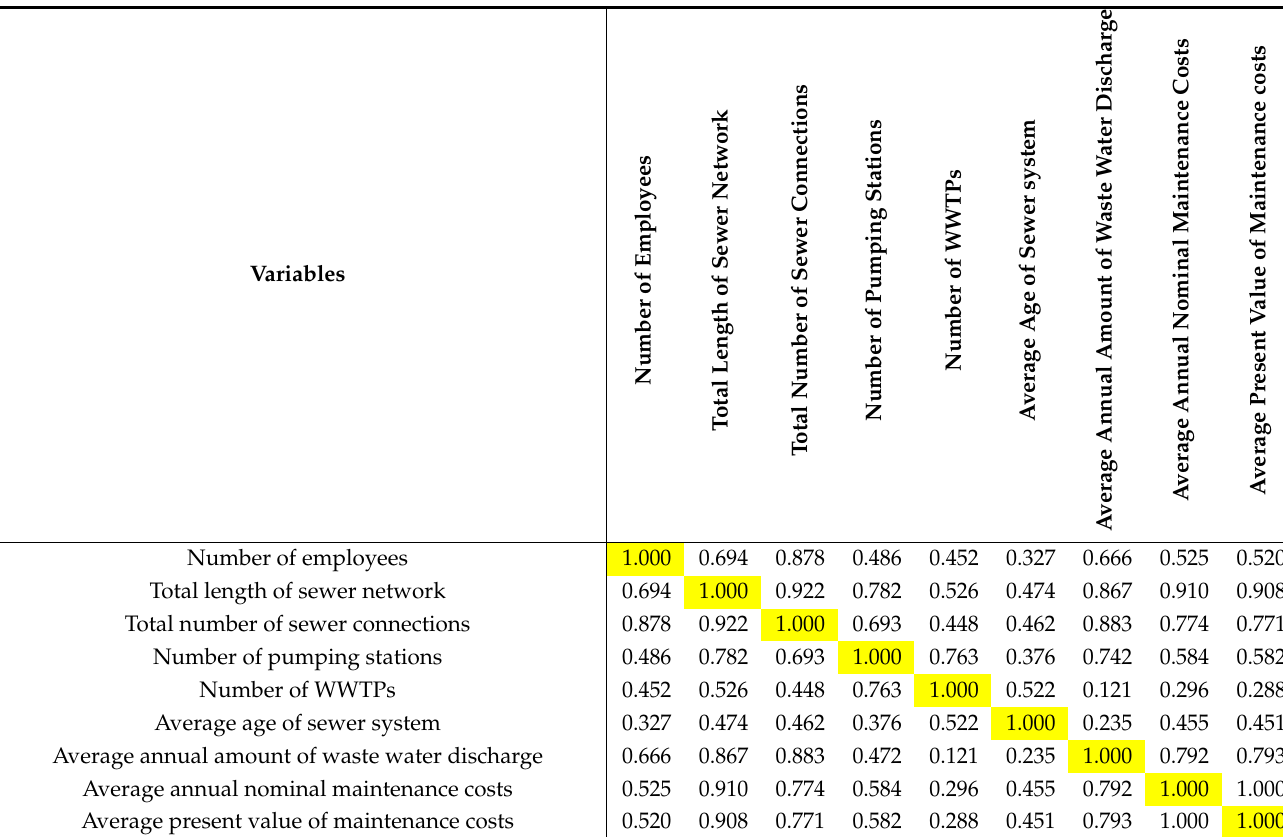
Table 5. Correlation coefficients of independent and dependent variables.